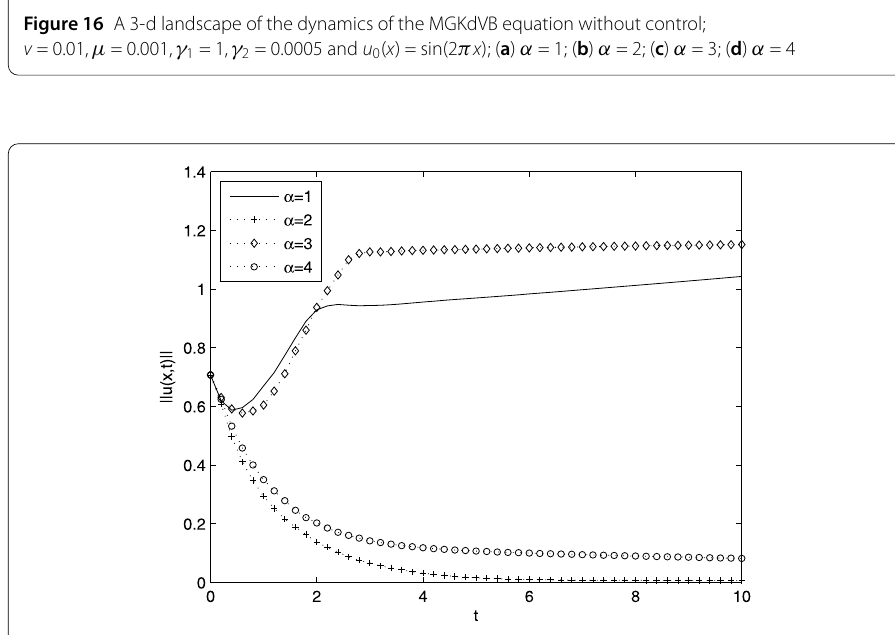
Figure 17 The L 2 -norm of u ( x , t ), (cid:7) u ( x , t ) (cid:7) , versus time for various values of α without control; v = 0.01, μ = 0.001, γ 1 = 1, γ 2 = 0.0005 and u 0 ( x ) = sin(2 π x